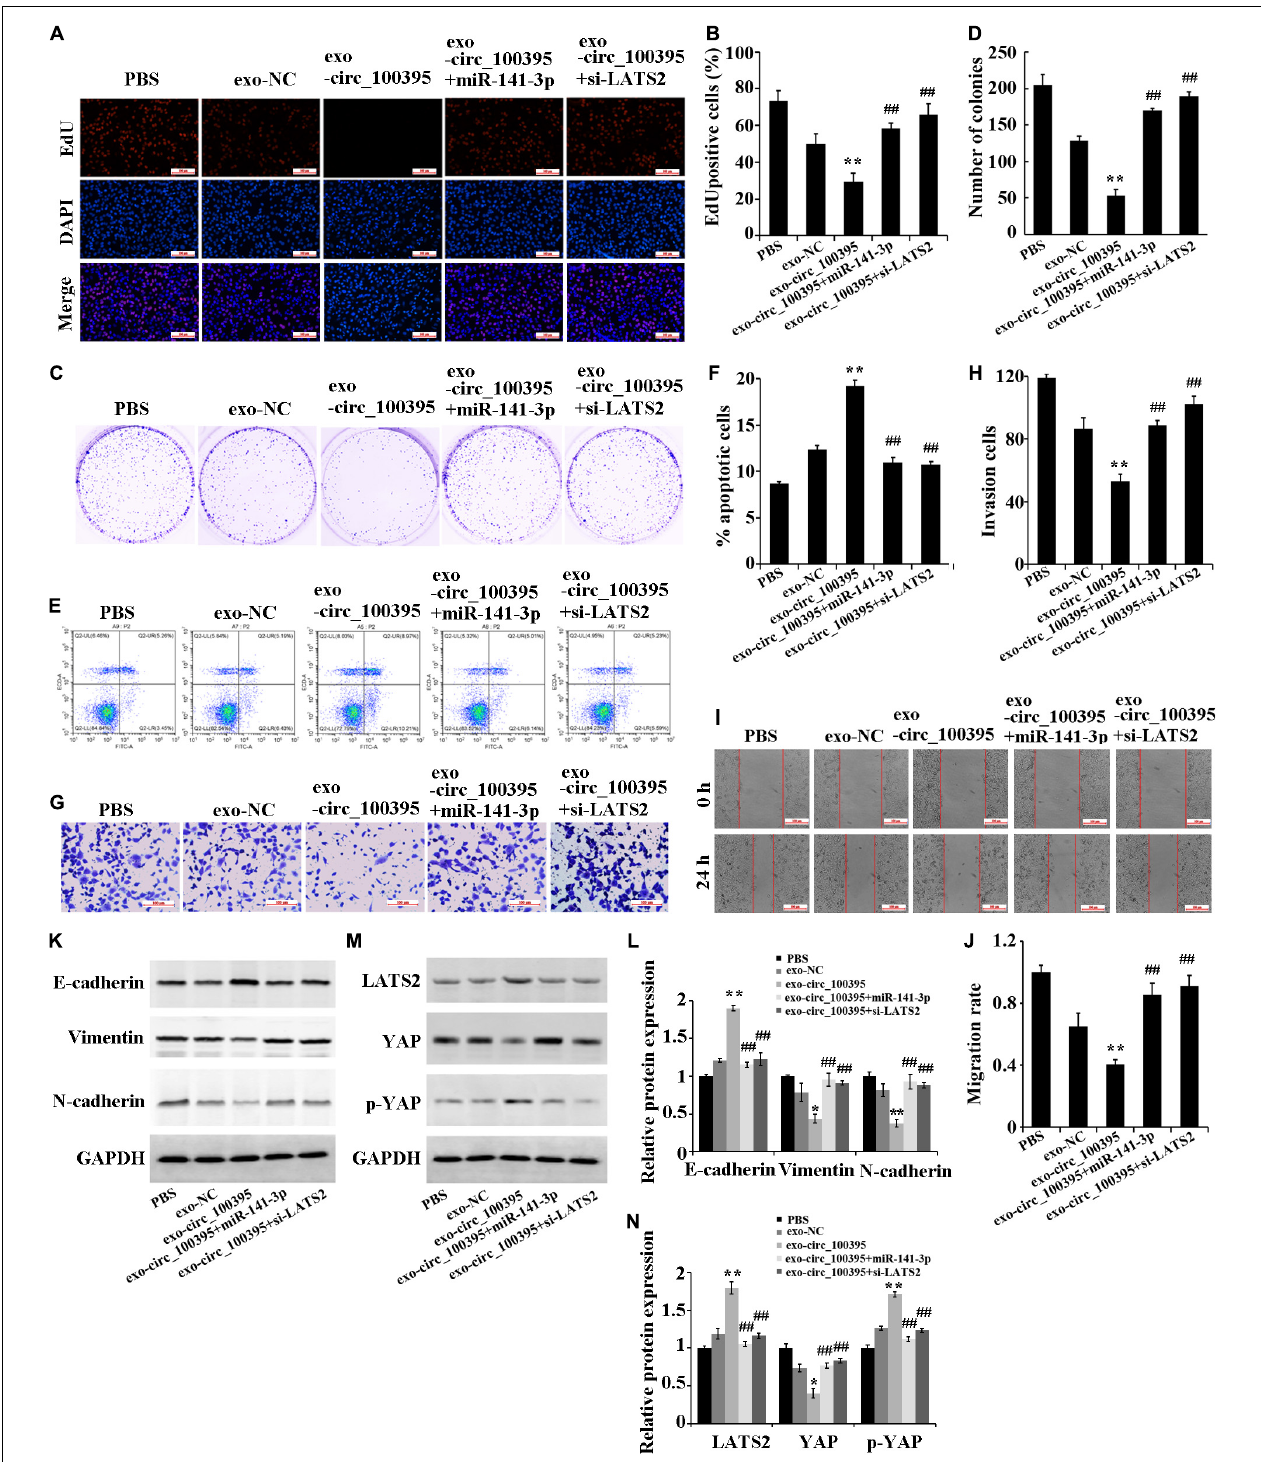
FIGURE 6 | Circ_100395 carried by exosomes from AMSCs inhibiting NSCLC progression through the miR-141-3p/LATS2 axis. (A,B) EdU assay-based observation of cell proliferation; (C,D) Colony formation assay-based observation of cell viability; (E,F) Flow cytometry-based detection of cell apoptosis; (G,H) Cell invasion exposed via transwell assay; (I,J) Wound healing assay-based detection of cell migration; (K,L) Detecting expressed E-cadherin, vimentin, and N-cadherin protein in individual treatment groups via western blot; (M,N) Detecting expressed LATS2, p-YAP, and YAP protein in individual treatment groups via western blot. ** p < 0.01 vs exo-NC group, ## p < 0.01 vs exo-circ_100395 group.